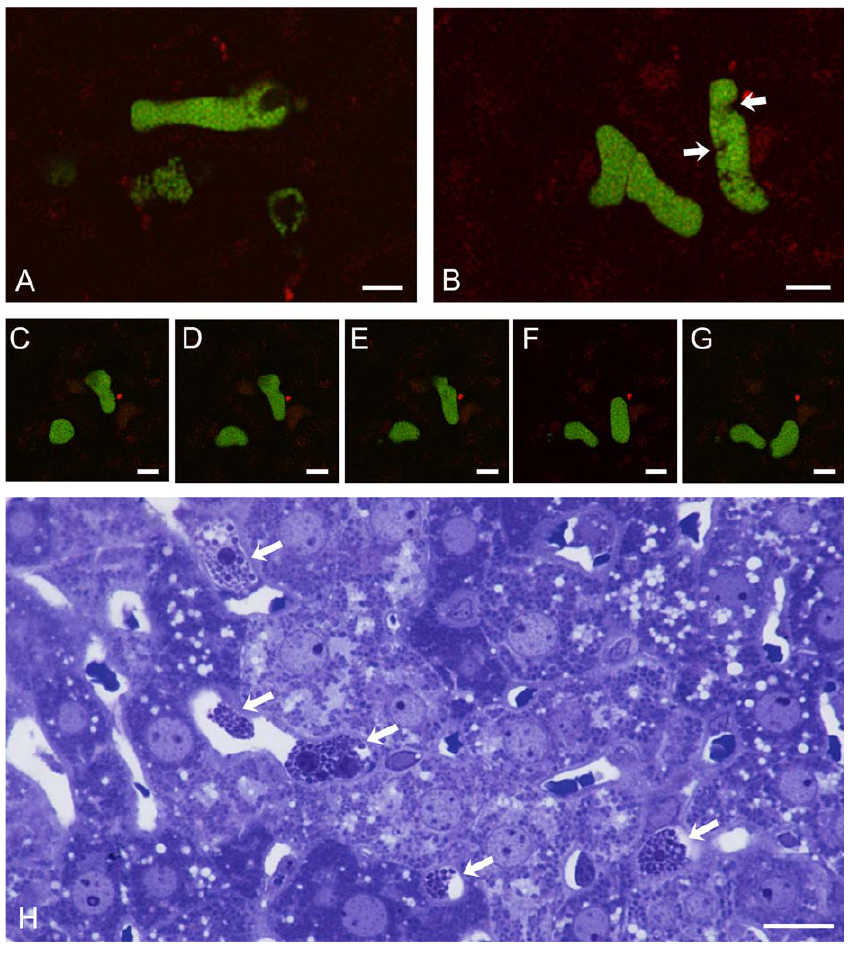
Figure 5. Dynamics of Merosome Transport in the Liver (A) Multiple merosomes separate from an EEF and are rapidly transported towards the central vein (see Video S6). Bar ¼ 10 l m. (B) Large merosomes move slowly within the sinusoidal lumen (see Video S7). Remnant bodies can be differentiated from merozoites by their larger size and lack of GFP (arrows). Bar ¼ 10 l m. (C–G) Individual frames of an intravital confocal video showing two smaller merosomes gliding along a sinusoid. Bars ¼ 10 l m. (H) Semithin liver section 52 h after infection with P. yoelii . Multiple merosomes, presumably released from a single EEF, can be found inside the sinusoids (arrows). Note the presence of remnant bodies in merosomes. Bar ¼ 10 l